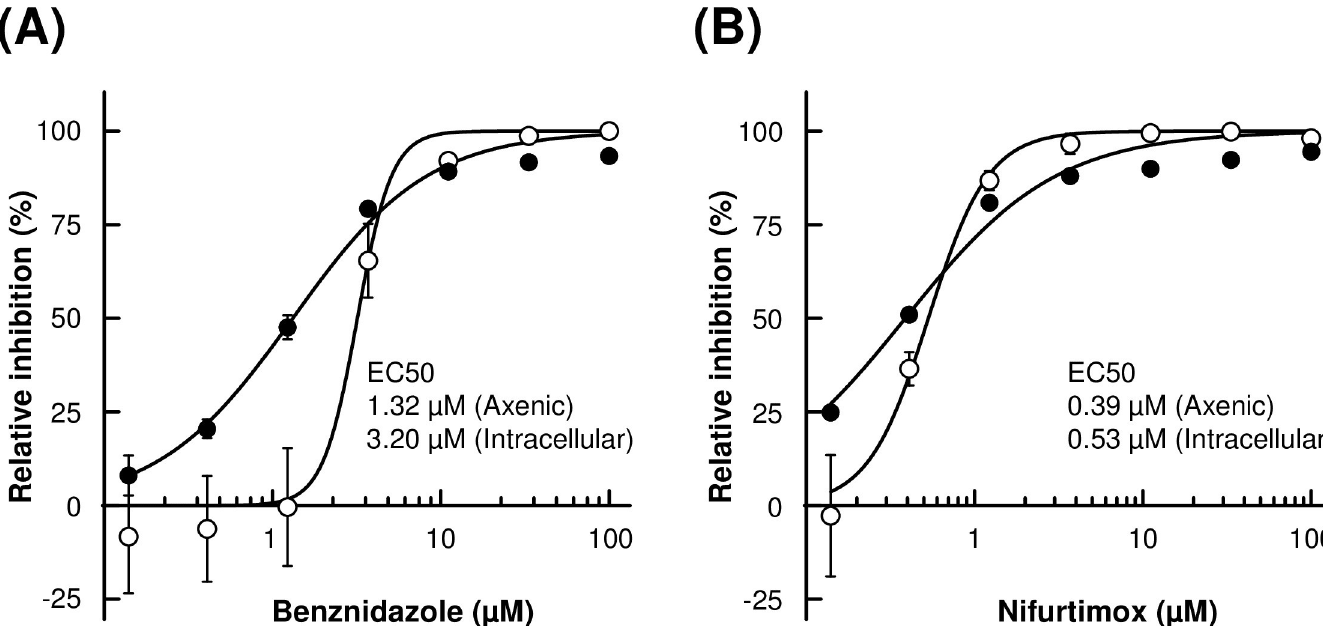
Fig 3. Effect of benznidazole and nifurtimox on axenic amastigotes and 3T3 intracellular amastigotes. Indicated concentration of benznidazole (A) or nifurtimox (B) was added to the culture of axenic amastigotes (closed circle) or 3T3 intracellular amastigotes (open circle). Growth of axenic culture was quantitated by resazurin assay. Relative inhibition was calculated from Relative Fluorescent Units and normalized to no drug control. Growth of intracellular amastigotes in the host 3T3 cells was calculated from the ratio of infected over uninfected host 3T3 cells and normalized to no drug control. Experiment was performed in triplicate, and mean values ( ± SD) were